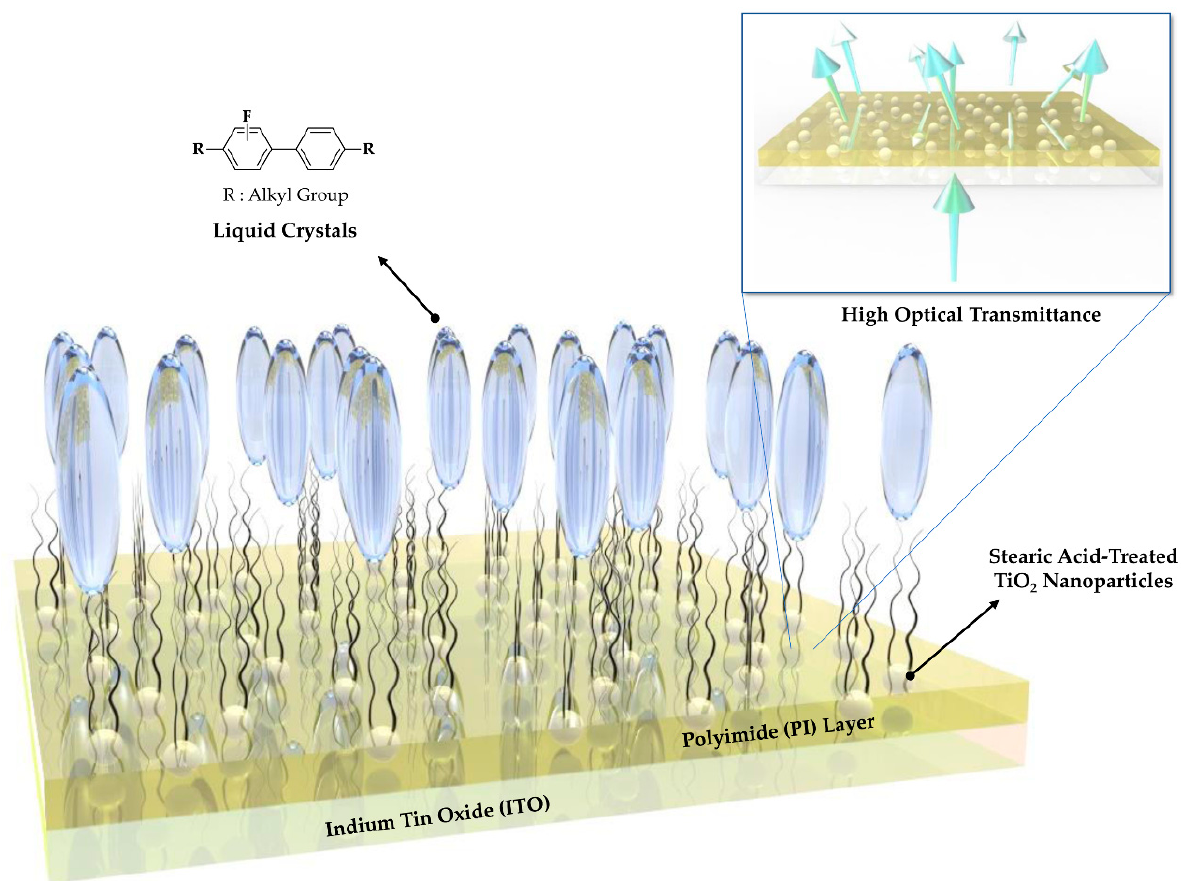
Figure 1. Schematic diagram of TiO 2 -embedded hybrid polyimide layer for liquid crystal displays.